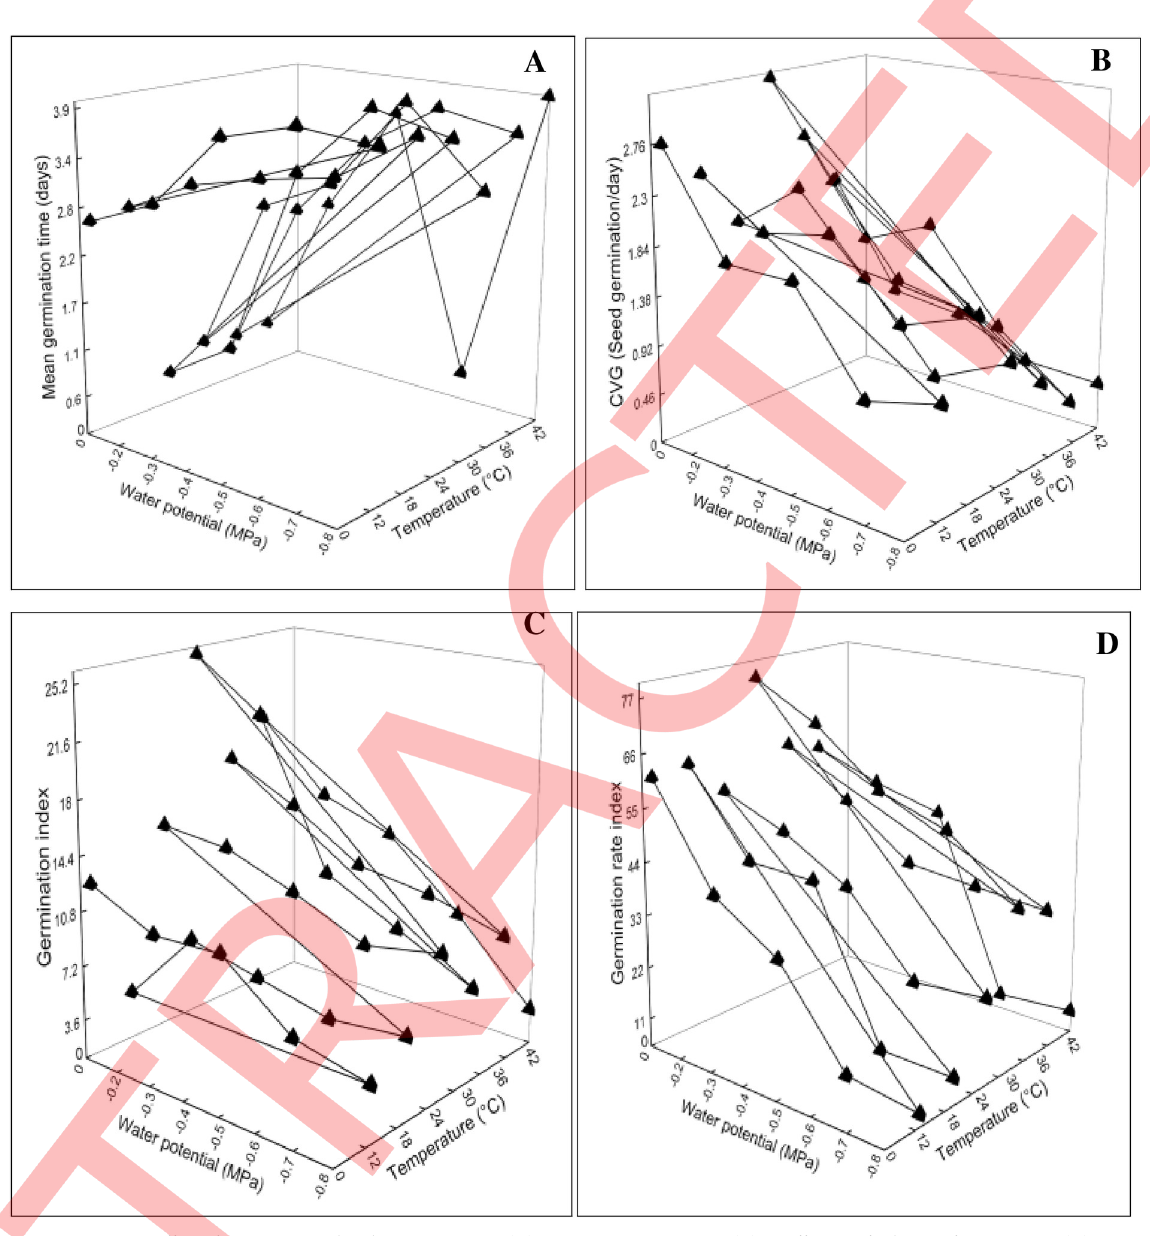
Fig 3. Interactive effect of water potential and temperature on ( A ) Mean germination time ( B ) Coefficient of velocity of germination ( C ) Germination energy ( D ) Germination rate index of chickpea var. NIFA 1995.